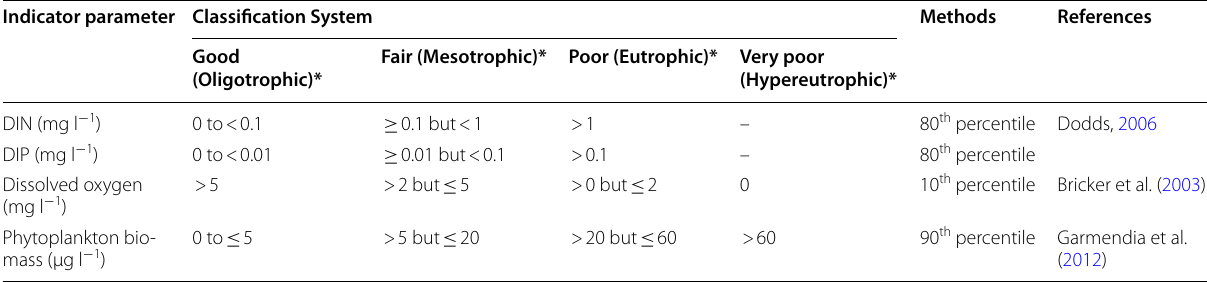
Table 3 Indicator threshold values to classify the eutrophic condition Indicator parameter Classification